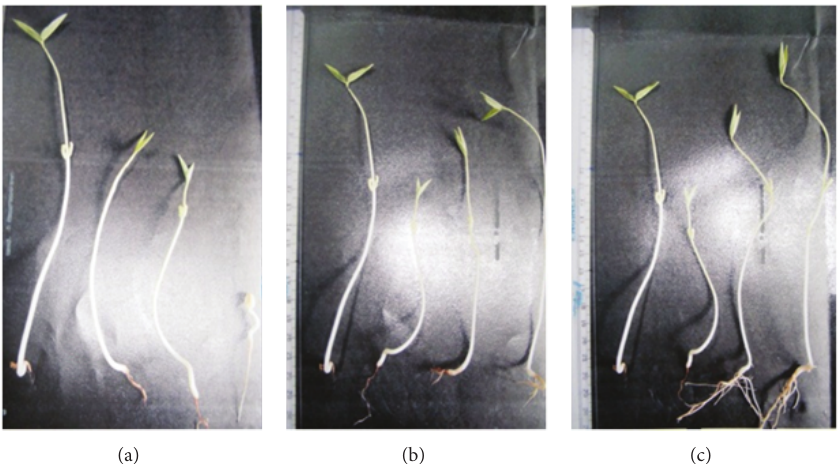
Figure 1: (a) Effect of NaCl on the growth of 10-day-old mungbean seedling. (b) Effect of NaCl on growth of 10-day-old mungbean seedling and its possible amelioration with 5 𝜇 M GA 3 . (c) Effect of NaCl on growth of 10-day-old mungbean seedling and its possible amelioration with 50 𝜇 M Spm.